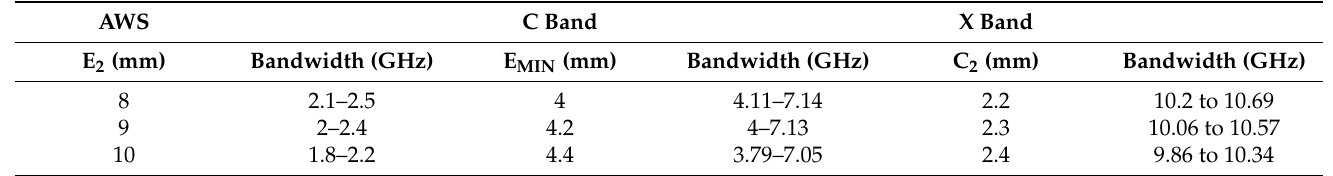
Table 2. Parametric variation of notched